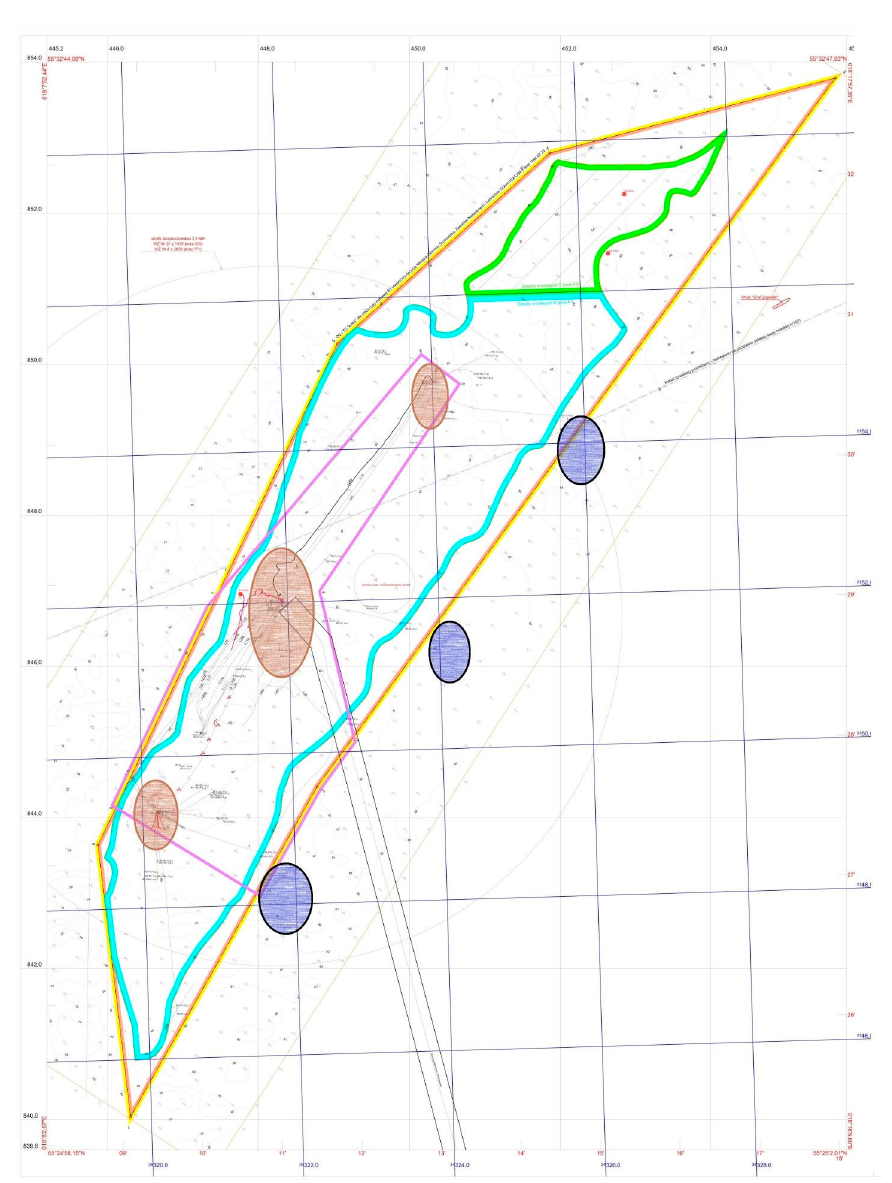
Figure 1. B3 oilfield map; brown areas indicate production zones, while blue areas are injection zones. Water is injected into the aquifer, creating a single front of water in the reservoir.